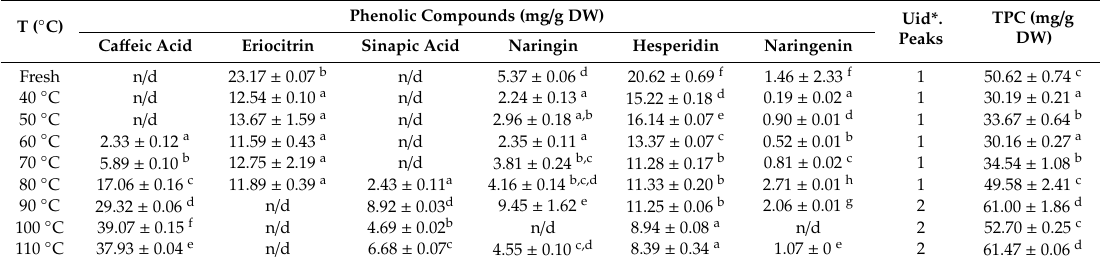
Phenolic Compounds (mg / g DW) Uid*.